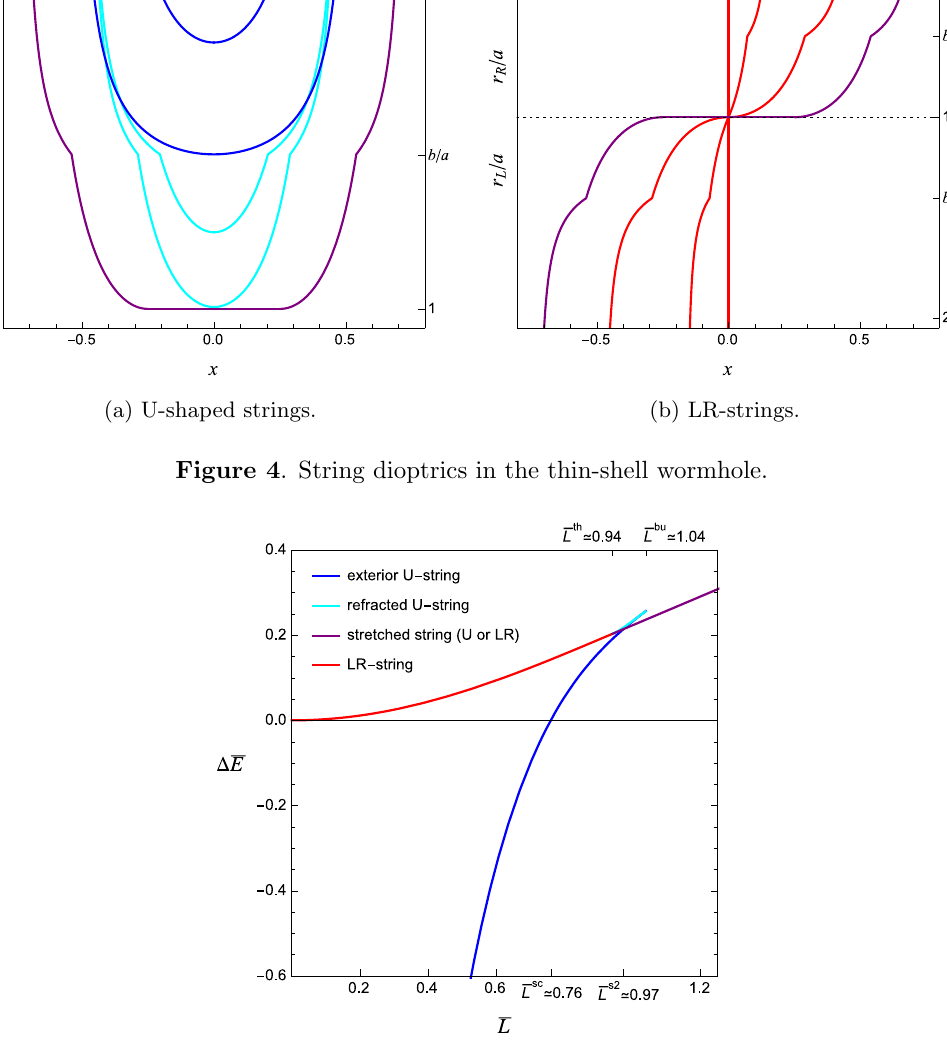
Figure 5 . The energy (cid:1) (cid:22) E of a quark-antiquark pair as a function of its separation (cid:22) L . Con(cid:12)gura- tions within the same boundary, dual to U-shaped strings, are plotted in blue, light blue and purple. Left-Right con(cid:12)gurations, dual to strings which traverse the throat, are plotted in red and